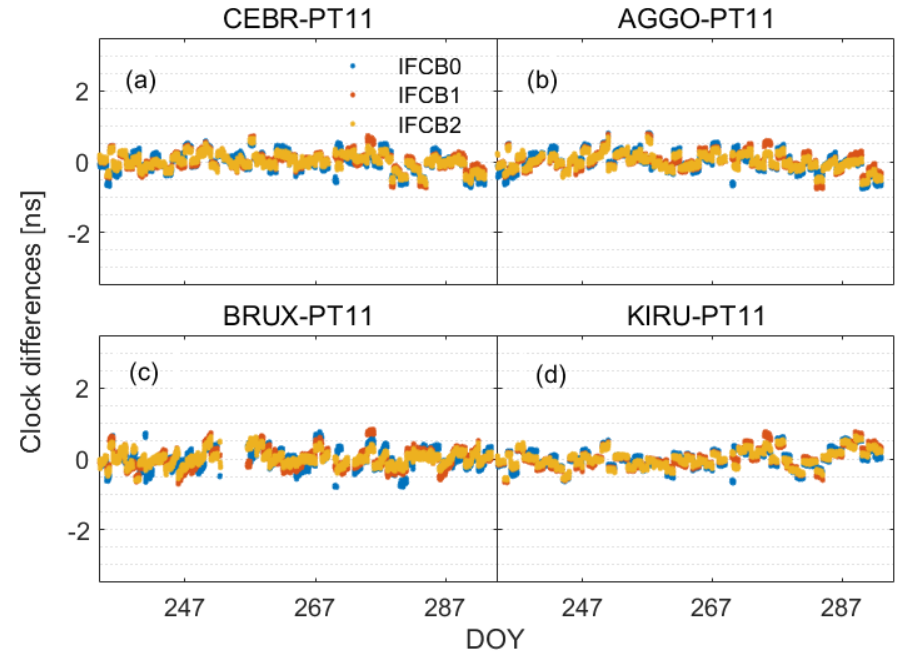
Figure 4. The clock differences series of some stations equipped with the same firmware versions and antennas: CEBR-PT11 ( a ) and AGGO-PT11 ( b ) are equipped with a SEPT POLARX4 receiver and SEPCHOKE MC antenna; BRUX-PT11 ( c ) and KIRU-PT11 ( d ) are equipped with a SEPT POLARX4TR receiver but different antennae.